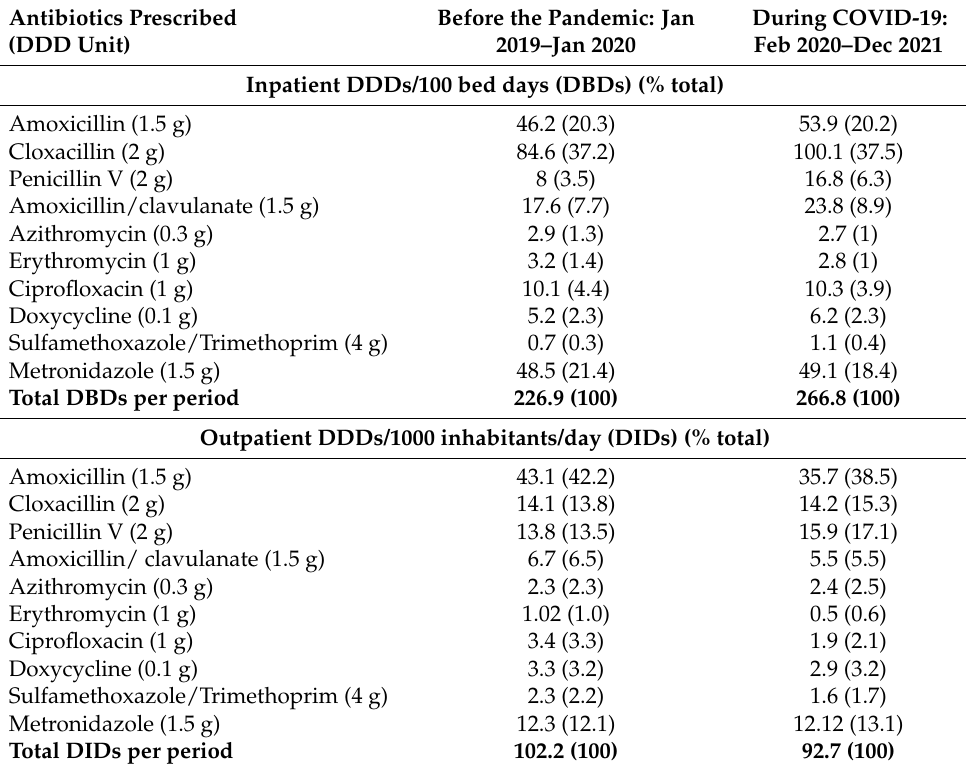
Table 3. Antibiotics prescribed by type in defined daily doses (DDDs) by inpatients and outpatients at Vila Central Hospital, Vanuatu before and during COVID-19: January 2018 to January 2020 and February 2020 and December 2021, respectively, with percentage of total consumption and DDD unit of measurement.